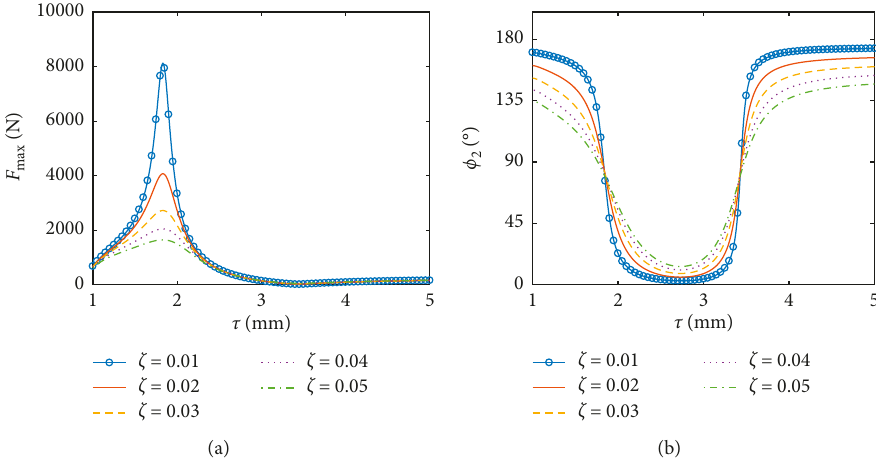
Figure 17: The amplitudes and the phases of the resultant force versus the thickness of the flexible baffle for R (a) the amplitude of the resultant force, (b) the phase of the resultant force.